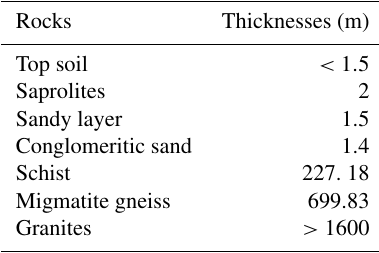
Table 4. Nature of formations.